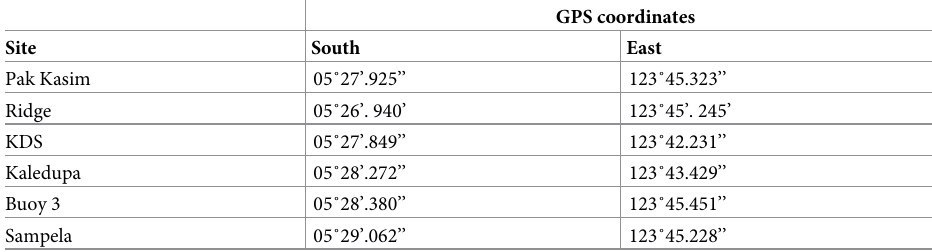
Table 1. Names and geographic coordinates of the sites